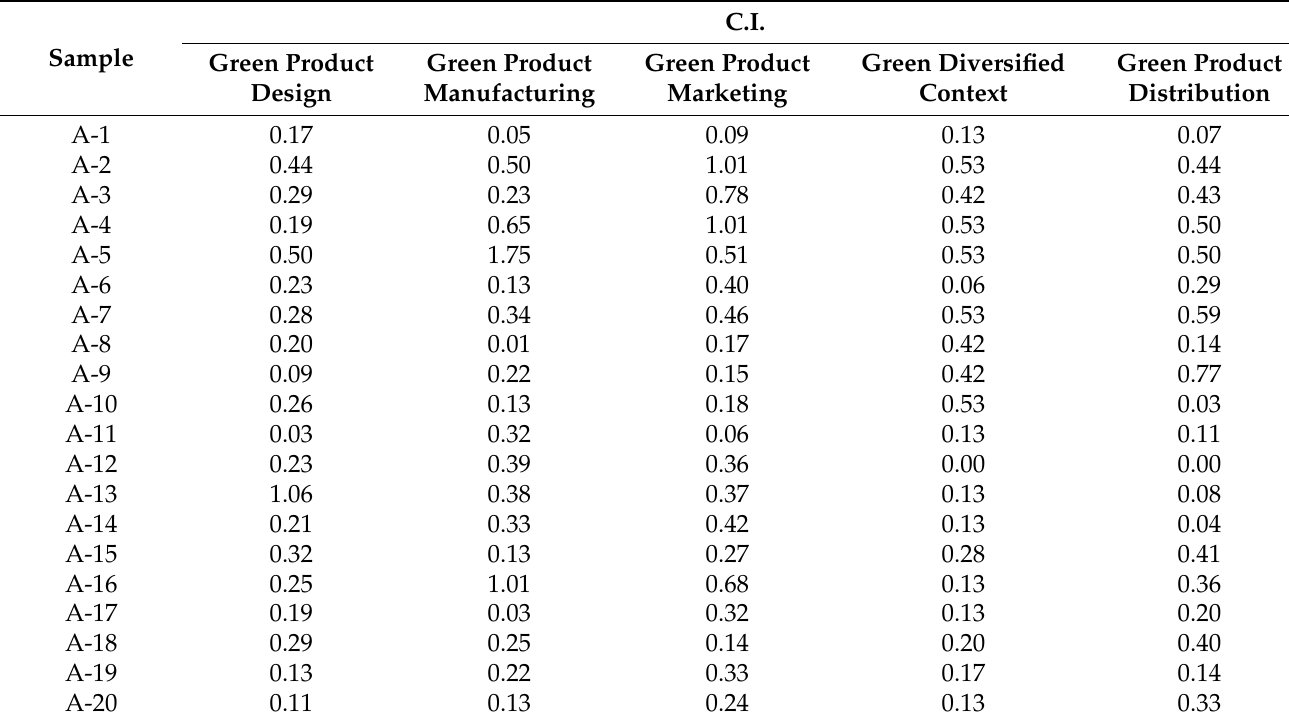
Table 4. Pretest results.